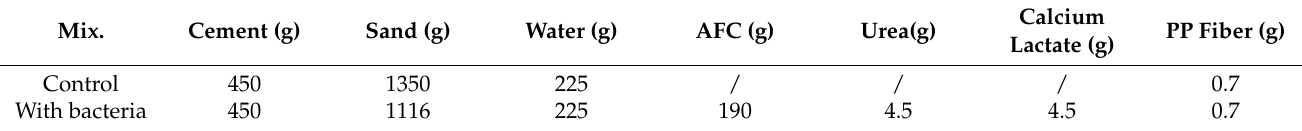
Table 1. Mixing proportions of cement mortars.